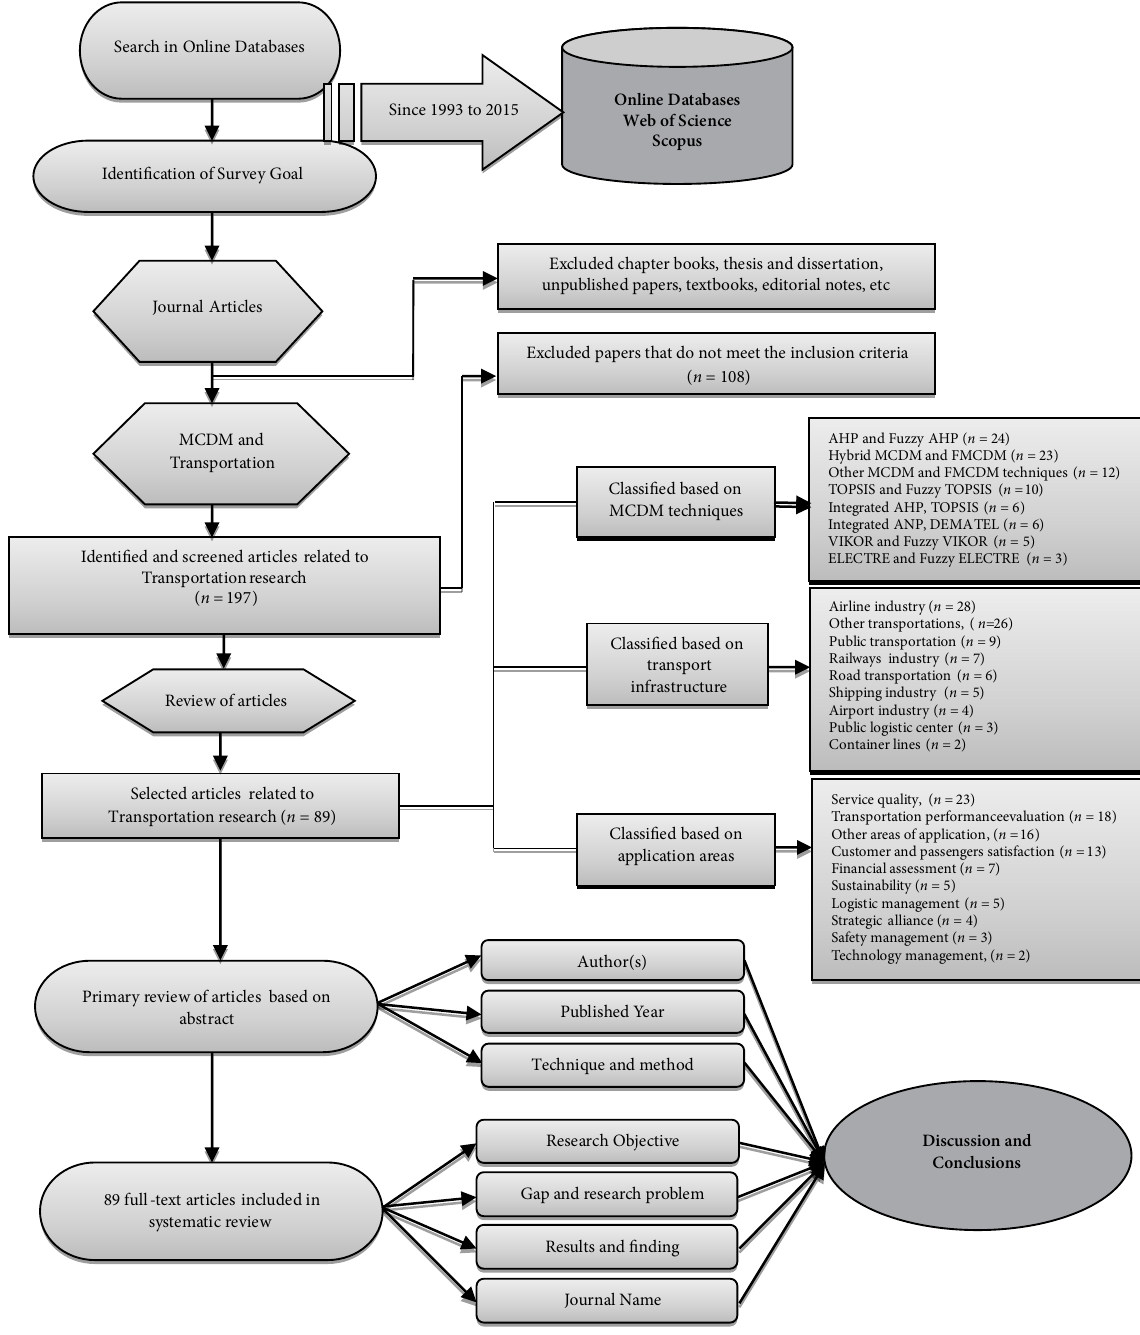
Fig. 1. Systematic review methodology of